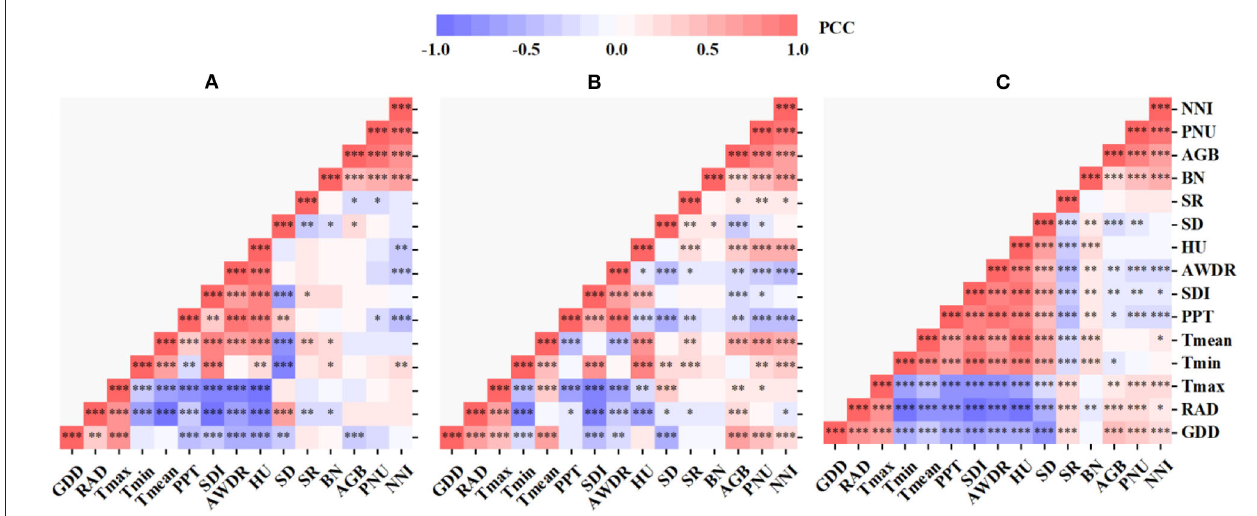
FIGURE 5 | Pearson correlation coefficient (PCC) analysis in agro-ecological zone 1 (A) , agro-ecological zone 2 (B) and across two agro-ecological zones (C) . “***”, “**”, and “*” note the significant correlation at 0.001, 0.01, and 0.05, respectively. GDD, RAD, T max , T min , T mean , PPT, SDI, AWDR, HU, SD, SR, BN, AGB, PNU, and NNI refer to growing degree days, solar radiation, seasonal maximum, minimum, and mean temperature, seasonal total precipitation, shannon diversity index, abundant and well-distributed rainfall, relative humidity, sowing dates, seeding rates, basal N, aboveground biomass, plant N uptake, and N nutrition index, respectively.